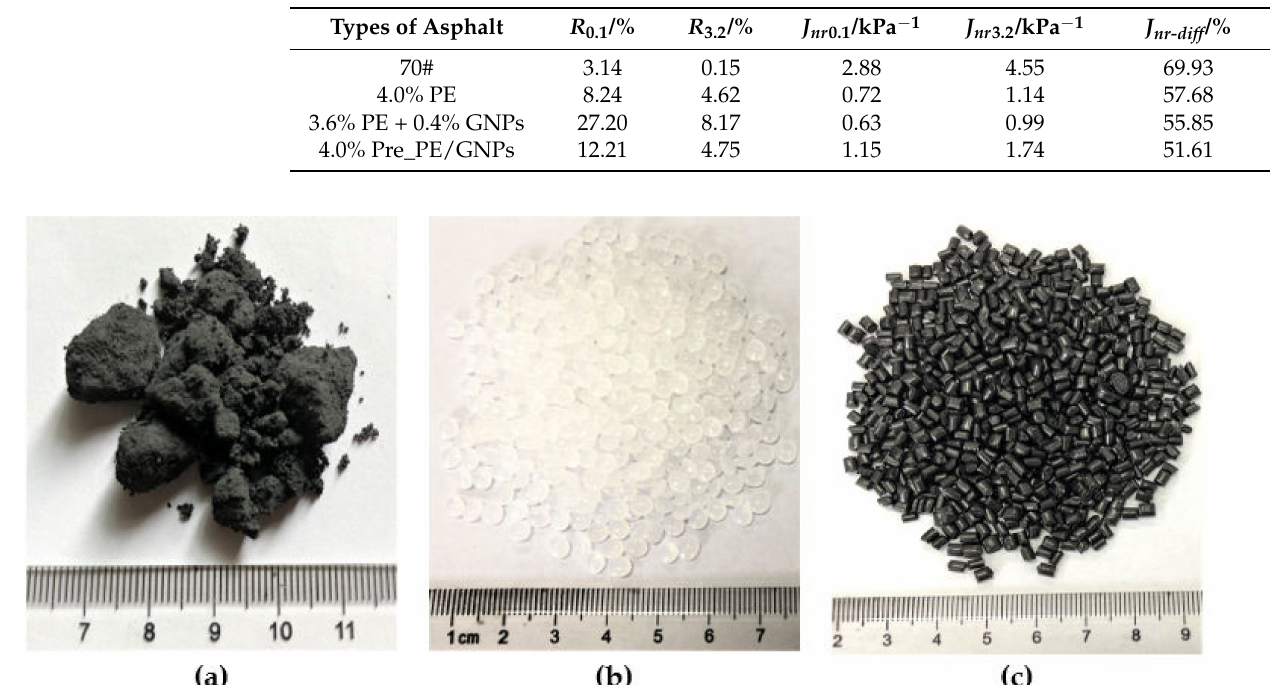
Table 3. Summary of test parameters for multiple stress creep recovery of asphalt binder.